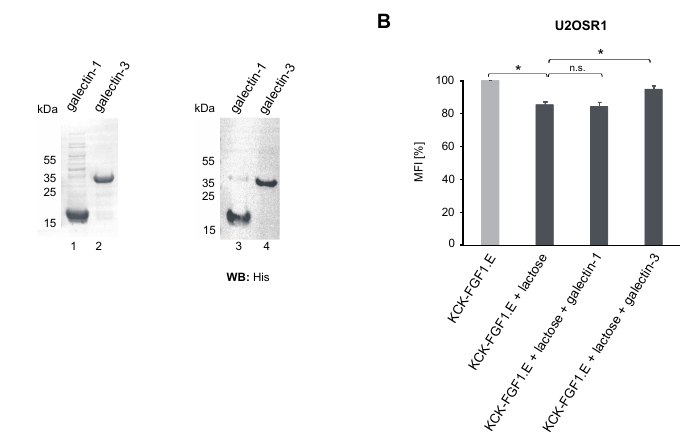
Figure 2. The impact of galectin-1 and -3 on the FGFR1-mediated uptake of KCK-FGF1.E. ( A ) Purity of recombinant galectin-1 and galectin-3 determined by SDS-PAGE (CBB) ( left panel ) and Western blotting using anti-His antibody ( right panel ). ( B ) Efficiency of KCK-FGF1.E internalization into U2OSR1 cells upon administration of recombinant galectins. Cells were treated with lactose for 15 min and then treated with KCK-FGF1.E labeled with DyLight550 in the presence of galectin-1 or galectin-3. After 30 min incubation on ice, cells were transferred to 37 °C for 20 min, washed to remove cell surface-bound, non-internalized proteins and then analyzed by flow cytometry. Results presented are mean values from three experiments ± SEM. The t- test was used to assess the statistical significance of measured differences in internalization; * p < 0.05, n.s.—not significant.